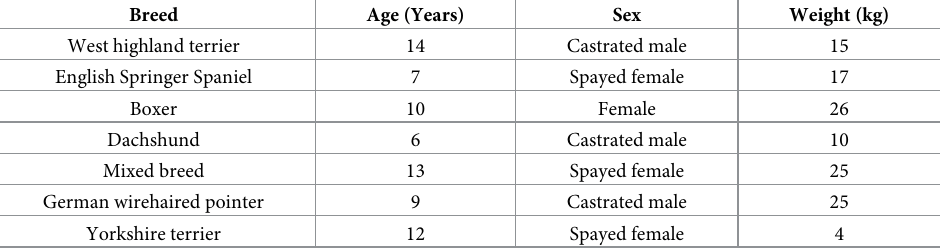
Table 1. Humane euthanasia was performed by the attending veterinarian according to stan- dard protocols in veterinary hospitals, and each heart was harvested within 10 minutes of euthanasia and kept in cold (4˚C) sterile cardioplegic solution (5.5 mM glucose, 0.5 mM adjusted to pH of 7.4) for 24 hours. Cardiac slicing protocol was modified from previous report [27]. Briefly, trans-mural sections of the LV free wall measuring 1 cm × 1 cm were excised. These tissue blocks were then affixed to the cutting block of a vibrating microtome (Campden Model 5100mz) using cyanoacrylate glue with the epicardial surface facing down, and then submerged in cold oxygenated slicing solution (30 mM 2,3-butanedione monoxime, 1 mM glucose, 10 mM HEPES, 6 mM KCl, 140 mM NaCl, 1 mM MgCl , 1.8 mM CaCl , 2 2 adjusted to pH of 7.4). The top ¼ section of the tissue at the endocardial surface was first sliced and removed to create a flat cutting surface. Then, slices of 350- μ m thickness were cut with a frequency of 75 Hz and amplitude of 1.5 mm, advancing at 0.1 mm/s. Resulting slices were washed once in culture media (M199 with 0.1% BSA, 1 × ITS, 10 mM 2,3-butanedione mono- xime, 1 × chemically defined lipid, 100 U/ml penicillin/streptomycin, 1 × HEPES) before being placed on a 0.3 μ m pore size transwell surface of a 6-well transwell culture plate at the air- media interface at 37˚C with 5% CO . Slices were subsequently treated with doxorubicin 2 Table 1. Demographic information of dogs used in this study. Breed Age